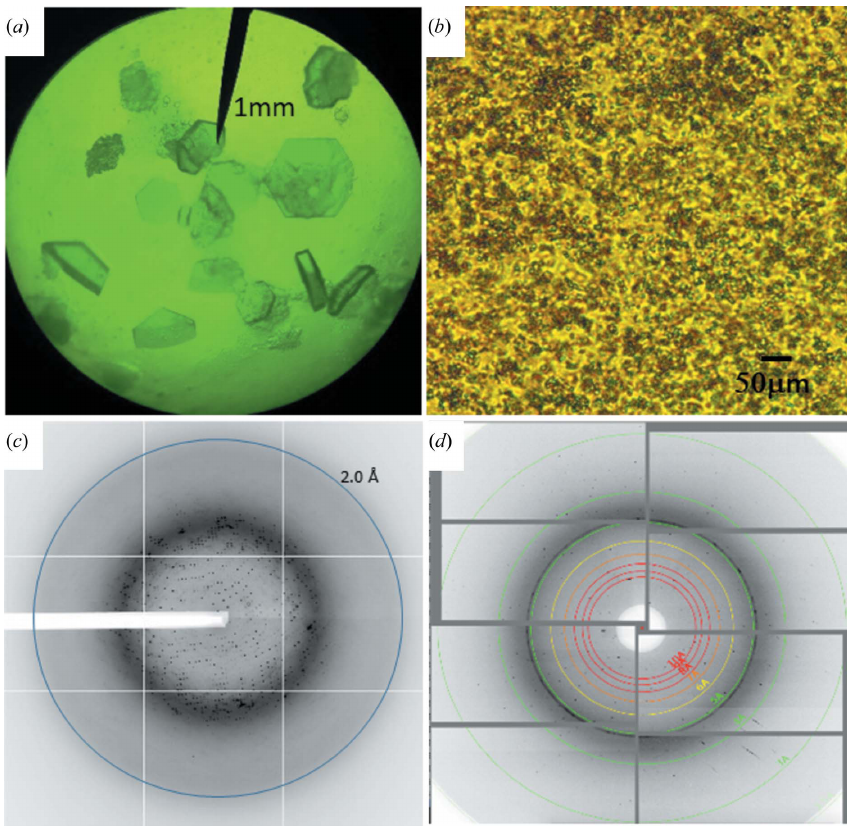
Figure 11 Examples of SaBphP1 crystals and diffraction patterns. ( a ) Wild-type PCM crystals, ( b ) T289H mutant PCM microcrystals as used at SACLA, ( c ) wild-type PCM diffraction pattern obtained at the synchrotron (APS, 19-ID-D), ( d ) T289H mutant diffraction pattern from